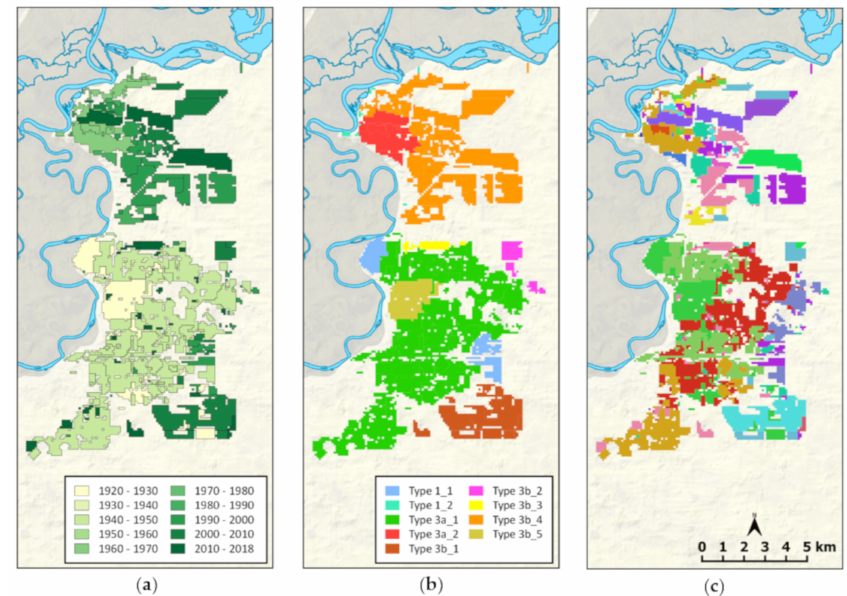
Figure 4. Method used to allocate recharge zones, showing ( a ) the timing of irrigation development, ( b ) classification of the vadose zone, and ( c ) resulting recharge